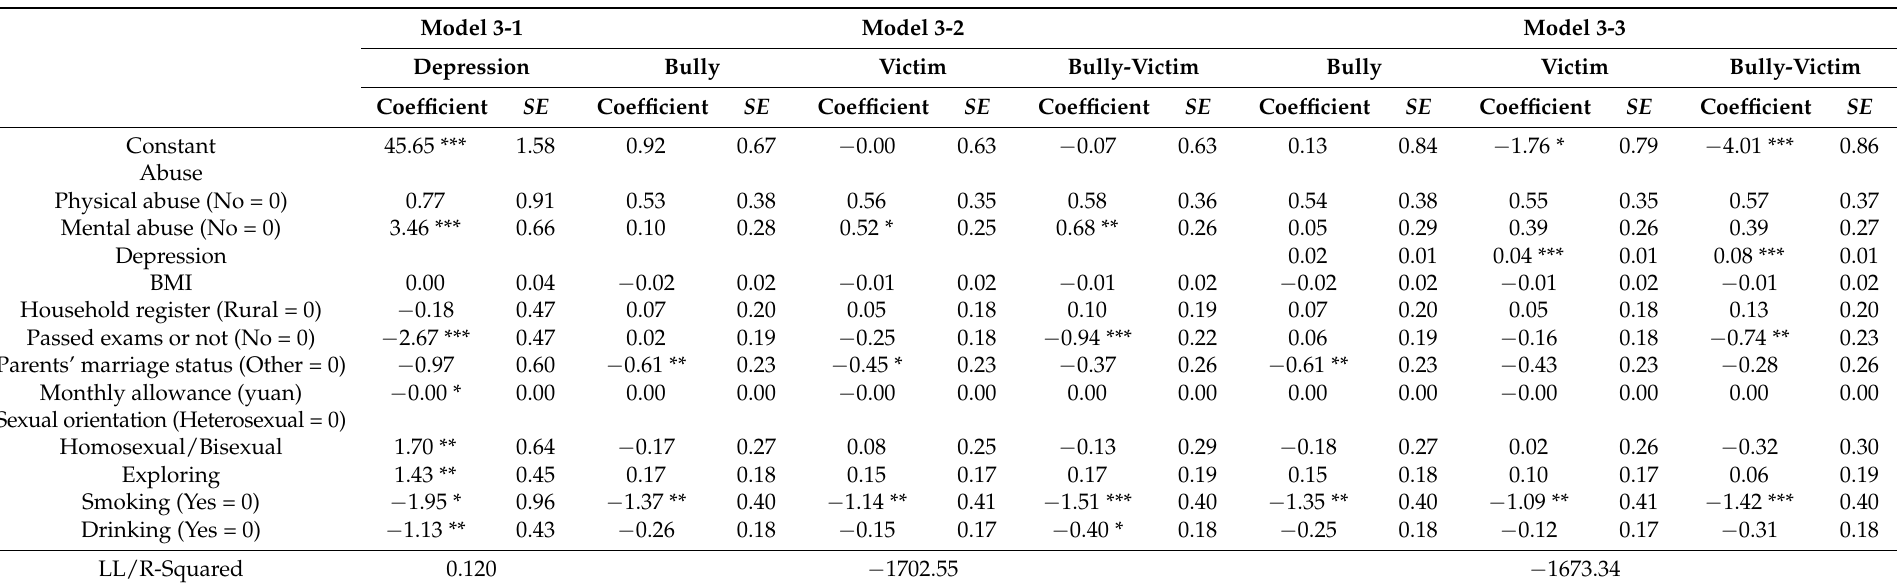
Table 3. Logit and OLS Regression Predicting Category of Bully Status and Depression for Females (n = 1475). Model 3-1 Model 3-2 Model 3-3 Depression Bully Victim Bully-Victim Bully Victim